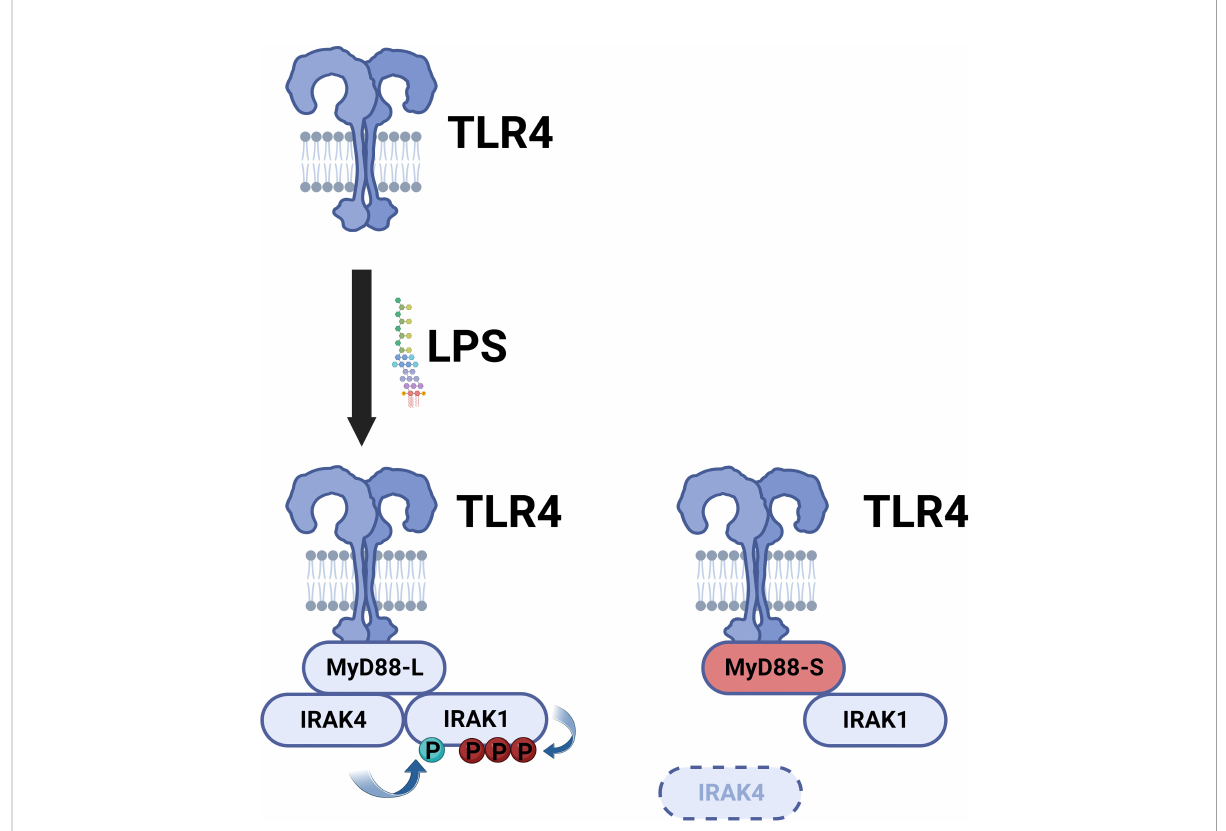
FIGURE 4 MyD88-S inhibits TLR signaling by preventing phosphorylation of IRAK1. Upon LPS stimulation, TLR4 recruits MyD88-L to the complex. MyD88- L in turn recruits IRAK4 and IRAK1. IRAK4 phosphorylates IRAK1, and IRAK1 auto-phosphorylates itself. MyD88-S is able to interact with TLR4 and IRAK1 but not IRAK4. Thus, MyD88-S prevents IRAK1 phosphorylation. For simplicity, not every protein in the signaling complex is depicted. Moreover, this signaling complex contains multiple copies of each peptide; for simplicity, only a single copy of each peptide is depicted in the diagram. Figure created with